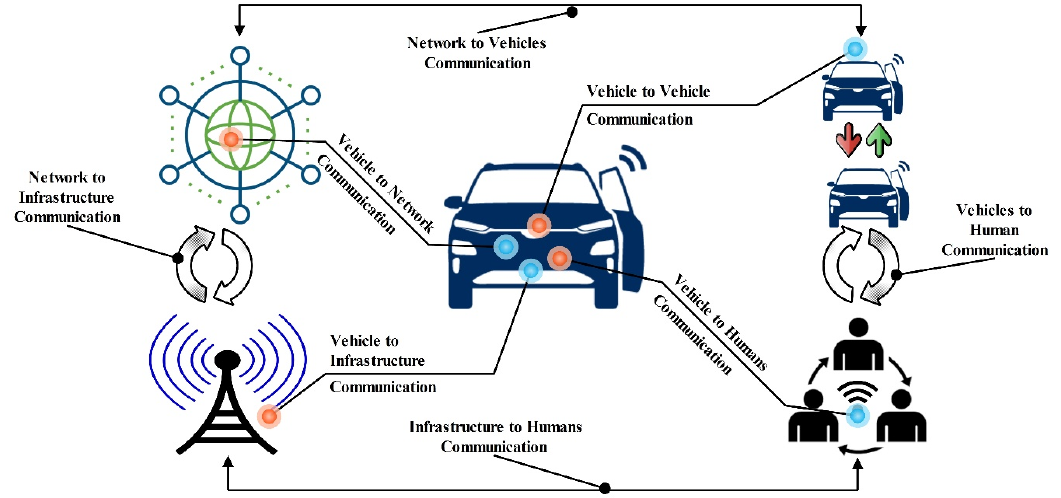
Figure 7. Vehicles to Every Things (V2X) communication including ( Vehicles to Vehicles (V2V), Vehicles to Infrastructures (V2I), Vehicles to Humans (V2H), Infrastructures to Humans (I2H), Vehicles to Networks (V2N), Infrastructures to Infrastructures (I2I), Networks to Vehicles